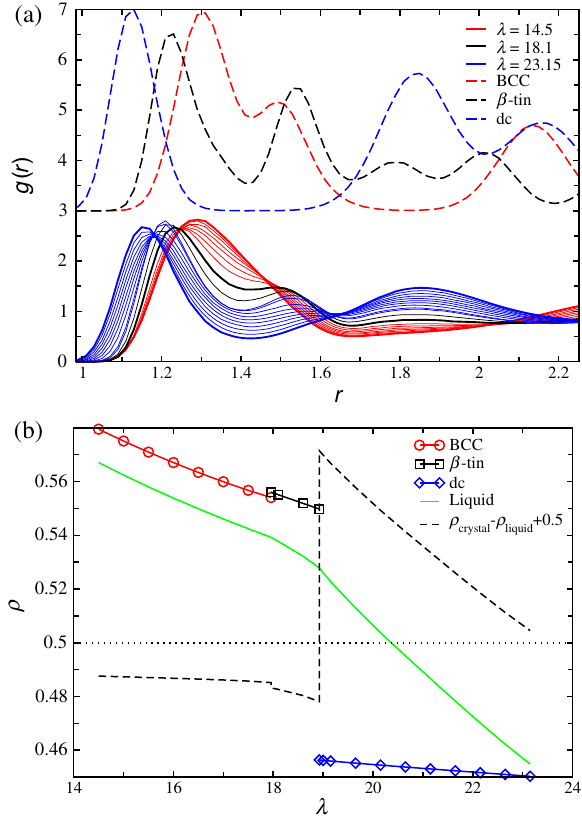
FIG. 12. λ dependence of density correlation and the crystal- liquid density difference. (a) Radial distribution function g ð r Þ for different values of λ along a line of constant thermodynamic driving force, β Δ μ ¼ 0 . 6 . The continuous lines are g ð r Þ for liquid states at λ ¼ 14 . 5 , 15, 15.5, 16, 16.5, 17, 17.5, 17.96 (red lines, the first one in bold, in the stability domain of bcc); λ ¼ 18 . 1 , 18.6 (black lines, the first one in bold, in the stability domain of β -tin); λ ¼ 18 . 92 , 19, 19.15, 19.65, 20.15, 20.65, 21.15, 21.65, 22.15, 22.65, 23.15 (blue lines, the last one in bold, in the stability domain of dc). The dashed lines are g ð r Þ for the bcc ( λ ¼ 14 . 5 ), β -tin ( λ ¼ 18 . 1 ), and dc ( λ ¼ 23 . 15 ), shifted verti- cally for clarity. (b) Density of the liquid (green continuous line) and the solids (bcc in circles, β -tin in squares, and dc in diamonds) for the state points with β Δ μ ¼ 0 . 6 , the same as in (a). The dashed line is the density difference between the liquid and the stable solid phase, shifted by 0.5 (the horizontal dashed line thus represents the 0 density difference